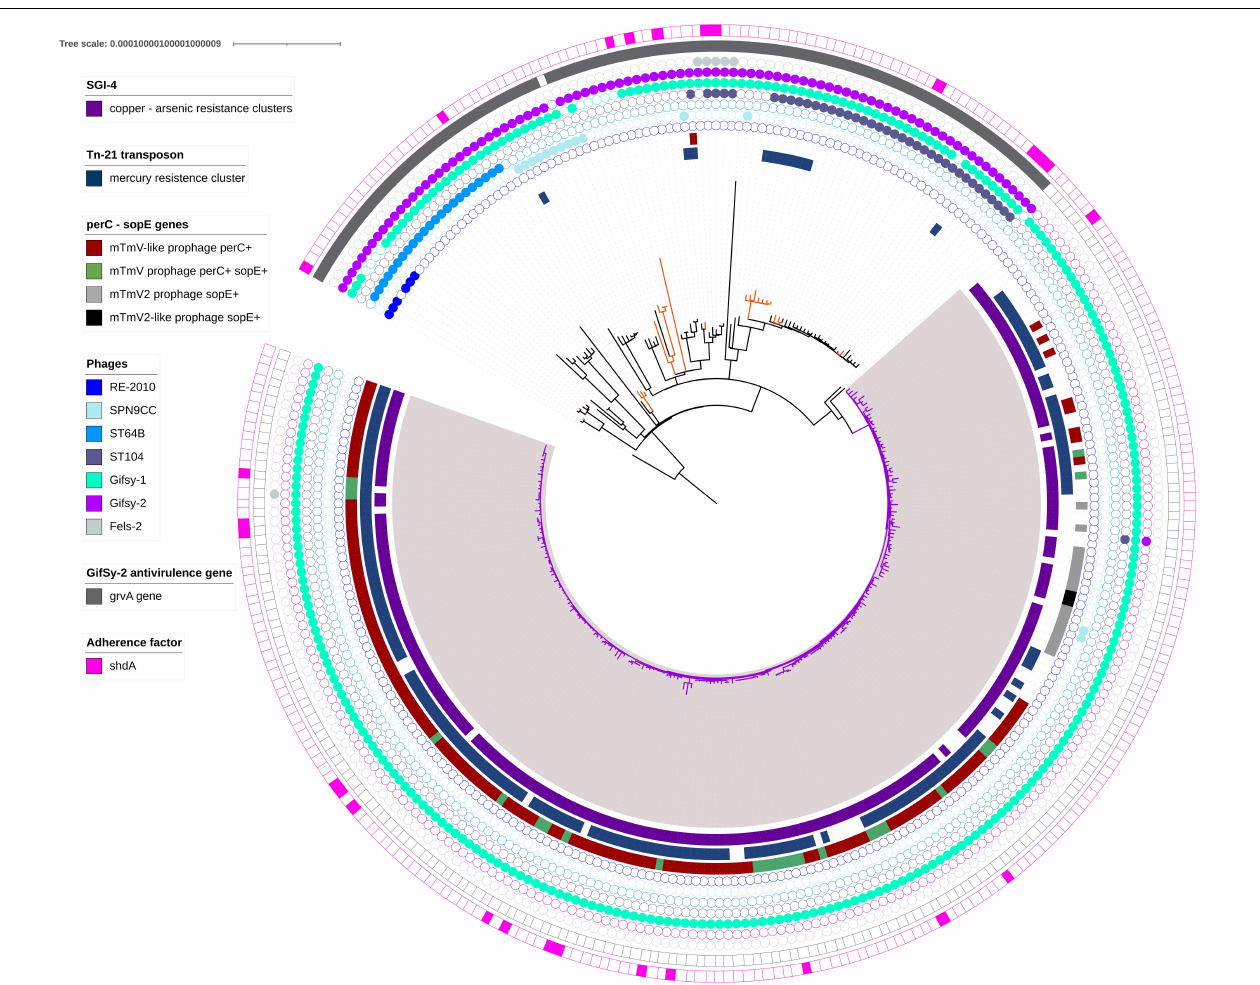
FIGURE 2 | SNP core genome phylogenetic tree of 298 S . Typhimurium and S . 1,4,[5],12:i:- strains. The main clade A is indicated with purple branches. This group is composed by 90% of S . 1,4,[5],12:i:- strains. Orange branches indicate S . 1,4,[5],12:i:- strains not belonging to the main group. Strips illustrate the presence of the Salmonella genomic island 4 (SGI-4) carrying arsenic and copper resistance genes (purple strip), mercury resistance genes ( mer TABCDE and mer R) in a Tn-21 like composite transposon (blue strip) and the mTmV, mTmV2 and mTmV-like phages (red, green, gray, and black strip). Presence/absence of phage is indicate with colored circles. The main differences observed of presence/absence of virulence factors are indicated – grv A and shd A genes – in gray and rose,